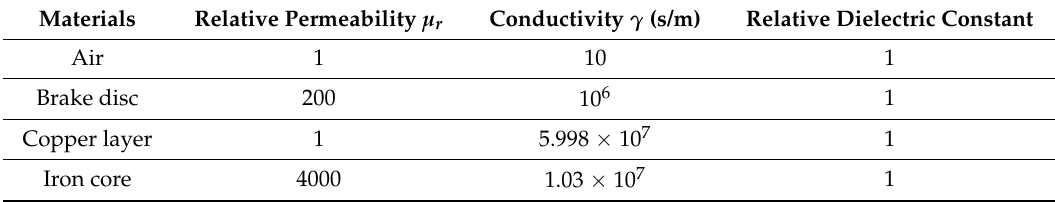
Table 2. Attribute parameters of related materials.